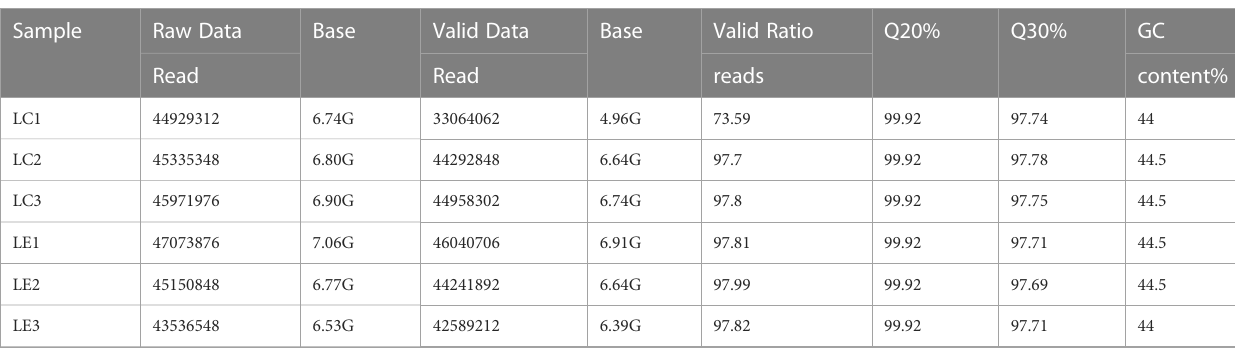
TABLE 1 RNA-seq data of samples.